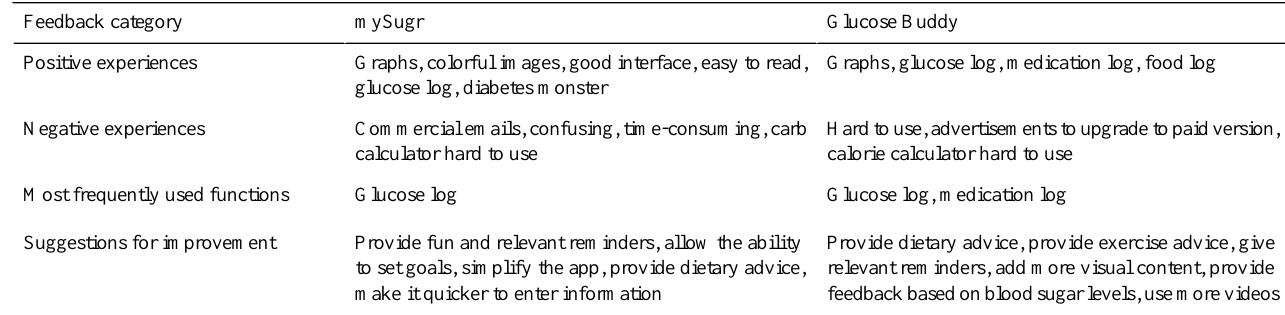
Table 5. Summary of participants' feedback and suggestions for improvement (n=6).